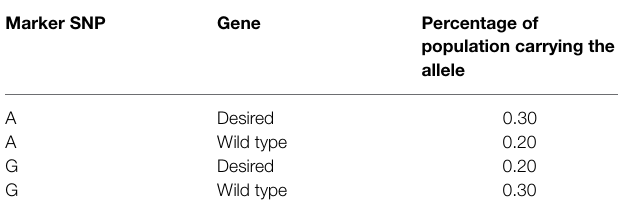
TABLE 4 | Hypothetical distribution of linkage between nearby marker and gene of